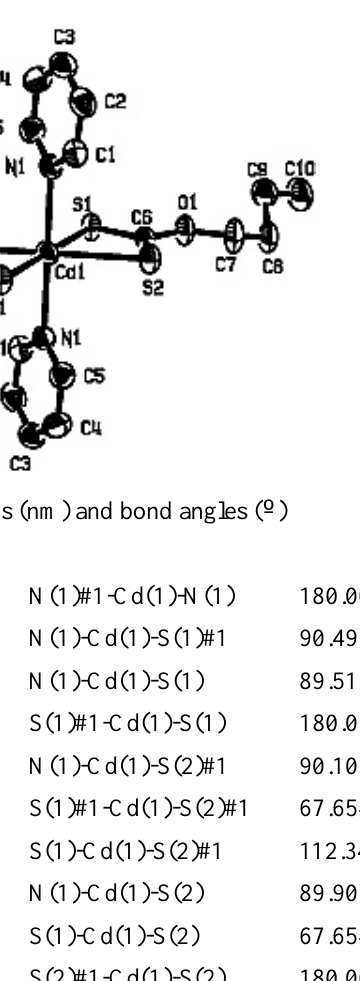
Figure 1. The atomic numbering scheme of the cadmium complex